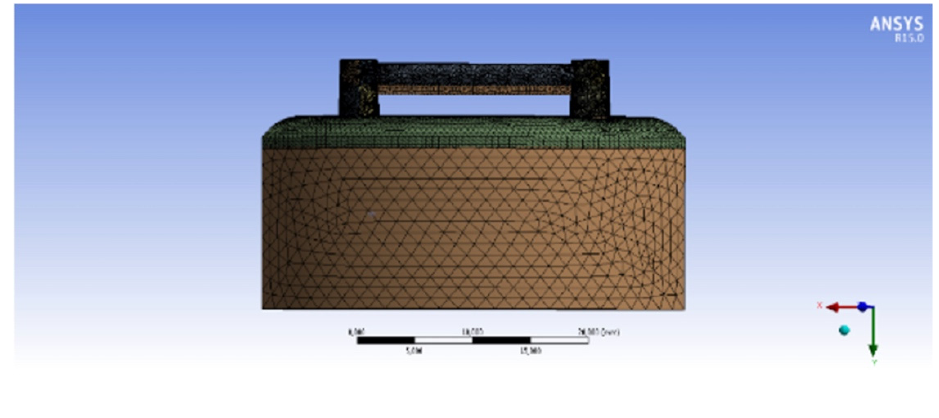
Figure 1. Model 2 after being meshed into elements.